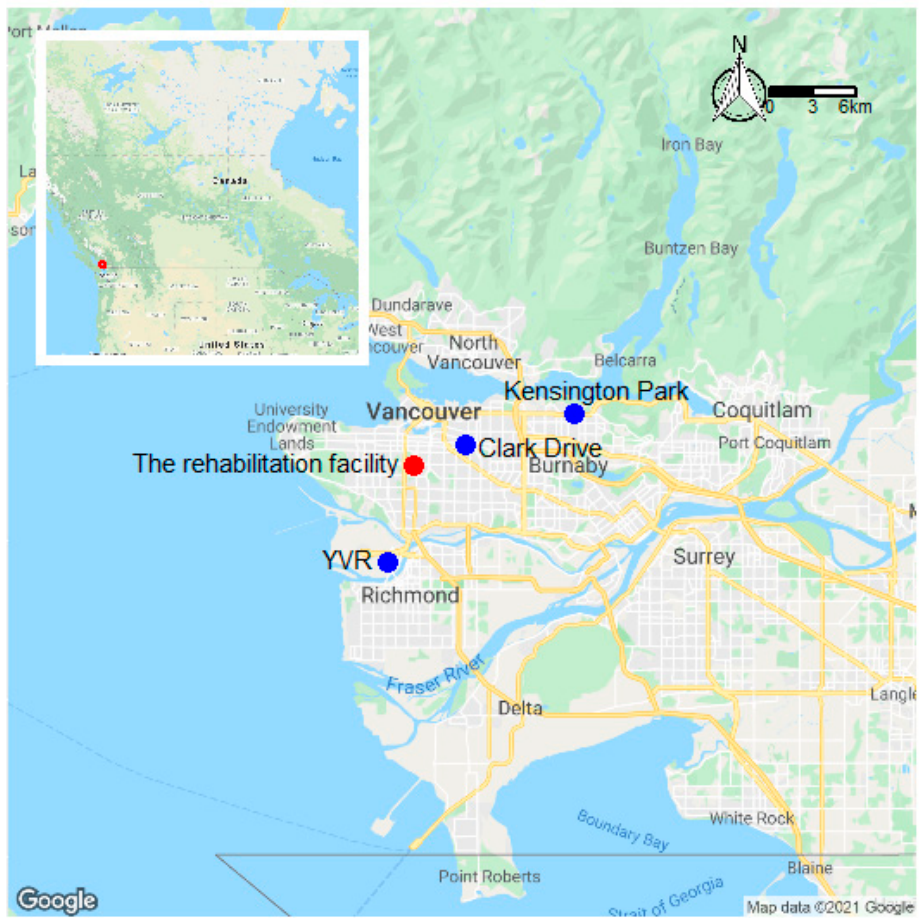
Figure 2. Locations of the rehabilitation facility (red dot) and three National Air Pollution Surveillance (NAPS) monitoring stations (blue dots) at Vancouver International Airport (YVR), Clark Drive, and Kensington Park in greater Vancouver, Canada. Location of greater Vancouver relative to North America (red square on inset map).